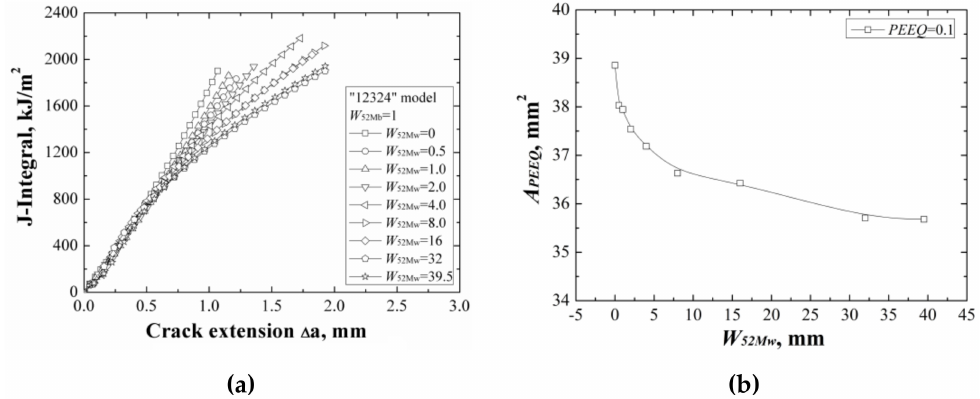
Figure 13. The J -resistance curves ( a ) and the areas surround by the ε p = 0.1 isoline ( b ) of different “12324” models with the same W 52Mb